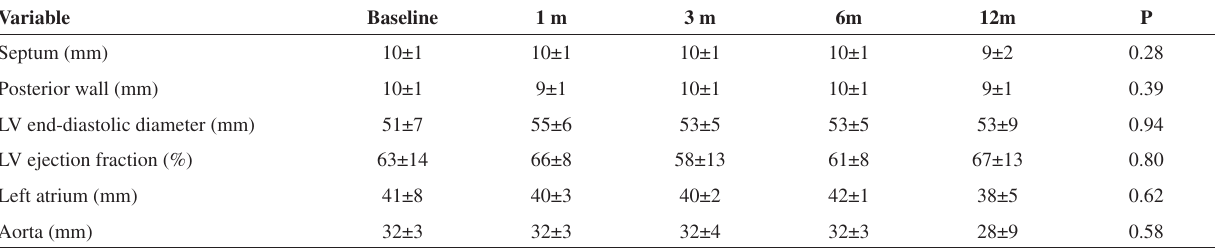
Table 6 - Echocardiography data at baseline and during the first year of follow-up.